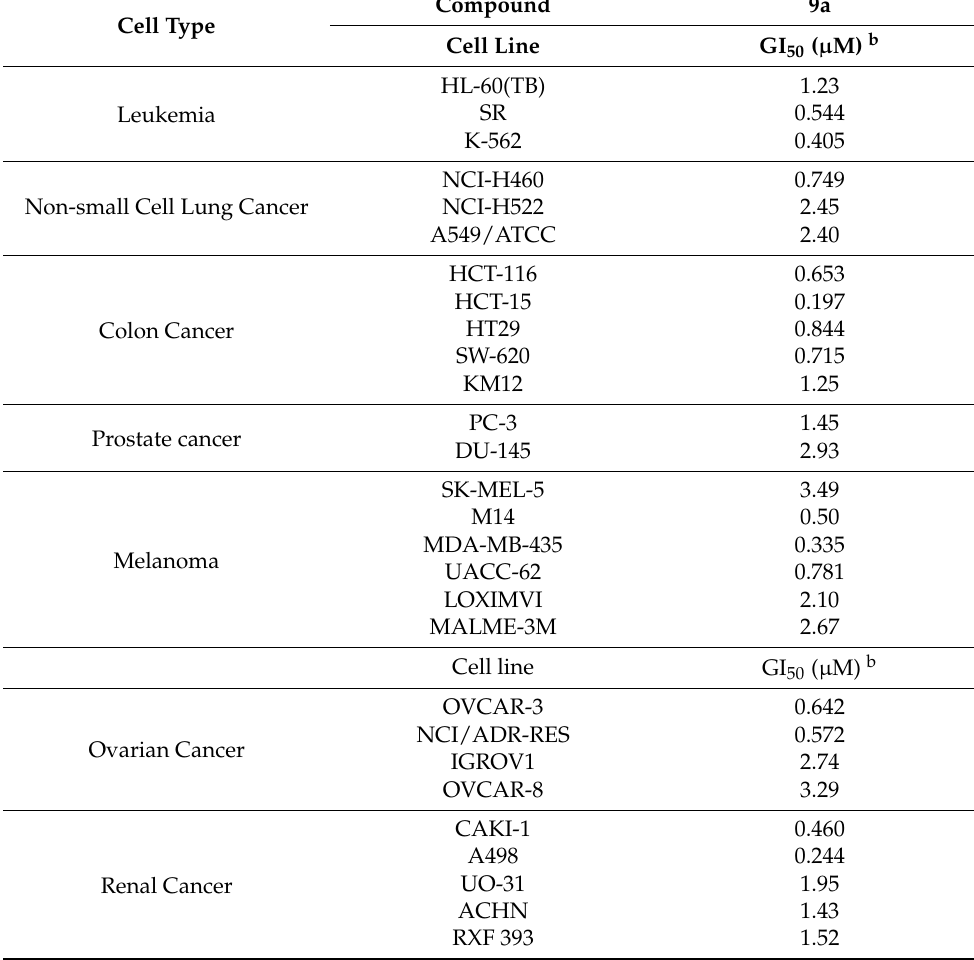
Table 4. Results of the 5-dose in vitro human cancer cell growth inhibition a for compound 9a